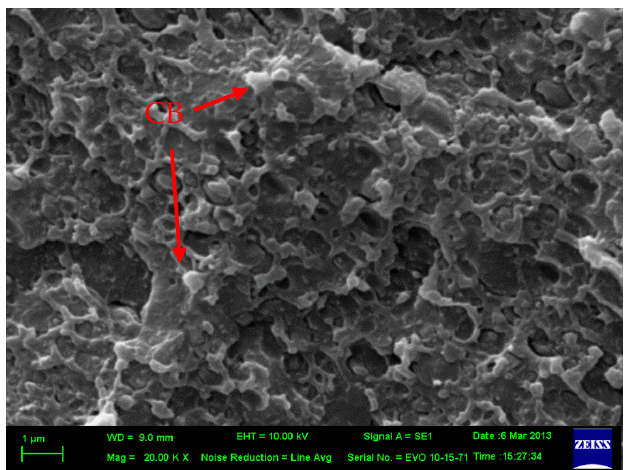
Figure 8. SEM image of the 8 wt % carbon black masterbatch (CBm) in the PC / ABS.